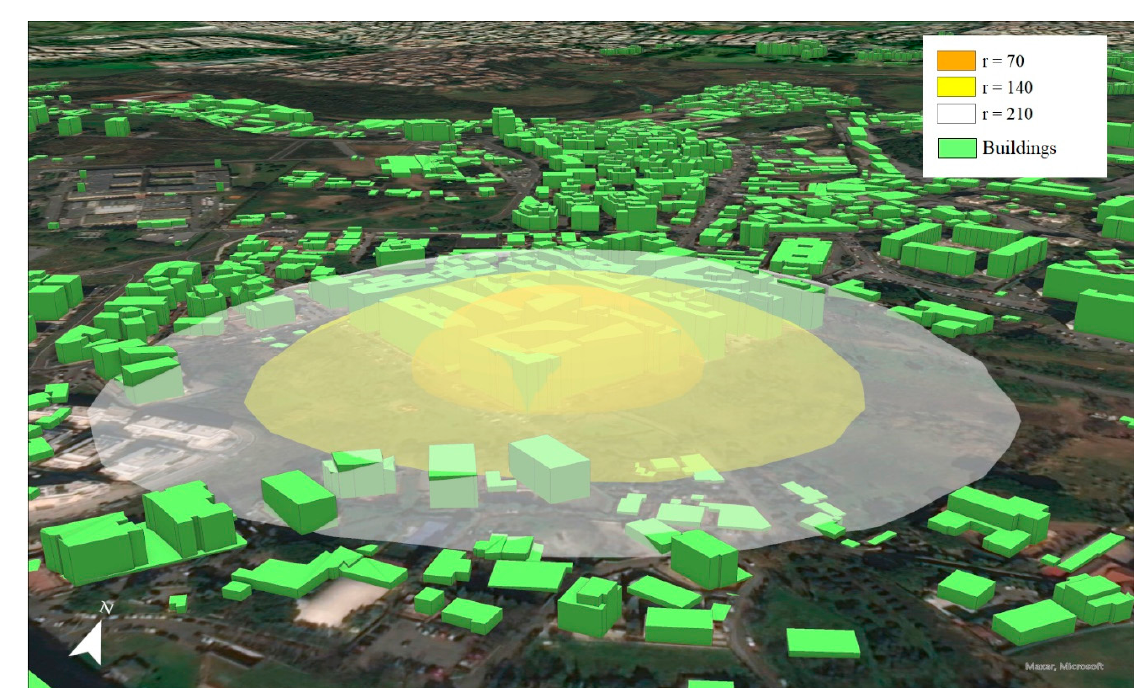
Figure 7. Prime three-dimensional model considering the possibility of representing the buffer zones in terms of semispheres, proceeding toward a system where all the elements (the same as in Figure 4) are reported as solid in ArcGIS Pro. Source: authors’ elaboration.